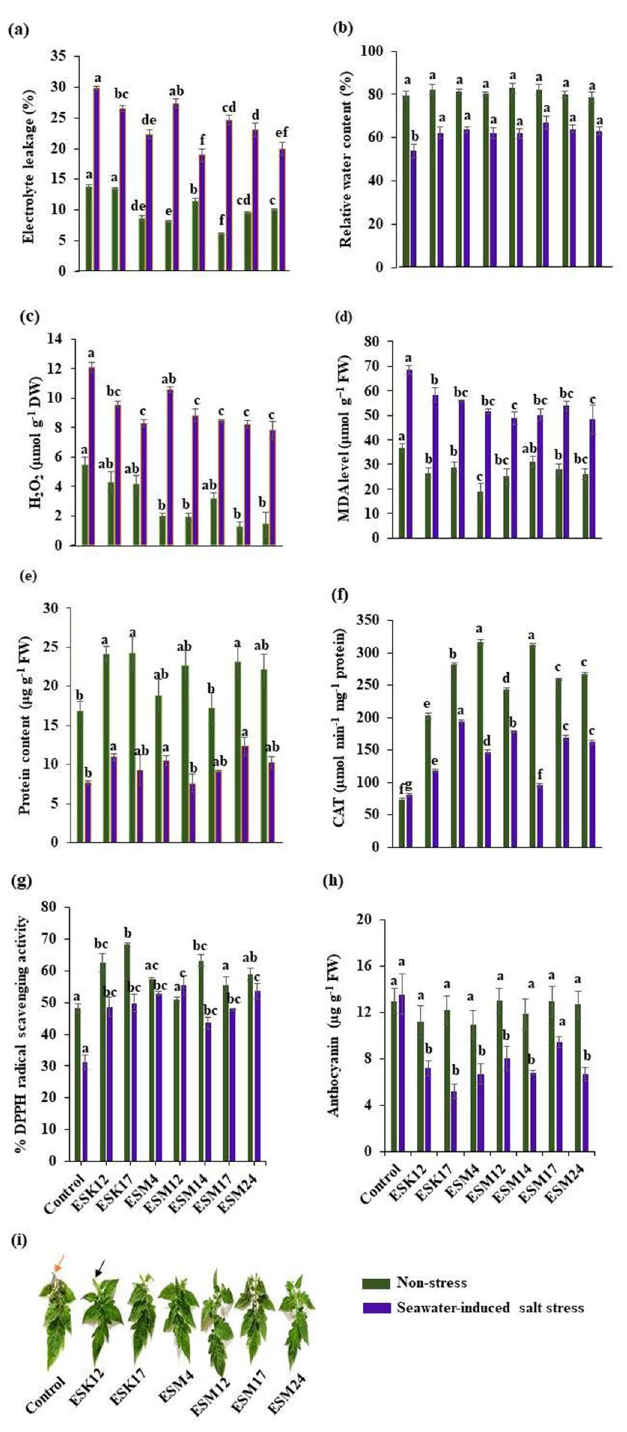
Figure 6. Halotolerant biofilm-producing rhizobacteria reduced sea water-induced salinity stress parameters and increased antioxidant defense systems in tomato plants. Pot-grown tomato plants were inoculated with different bacterial strains two times as described in “Methods” section. Analysis of ( a ) electrolyte leakage, ( b ) relative water content, ( c ) H 2 O 2 production, ( d ) MDA level, ( e ) Protein content, ( f ) CAT activity, ( g ) % DPPH radical scavenging activity, ( h ) anthocyanin content, and ( i ) anthocyanin accumulation. Orange arrow-head indicate anthocyanin accumulation and black arrow-head indicate no accumulation. Green and blue bars in the graphs represent non-stress and seawater-induced salt stress. Values [mean ± standard error (SE)] of each treatment were attained from three biological replications ( n = 3). Different letters represent significantly different data (P < 0.05 on Fisher’s least). FW fresh